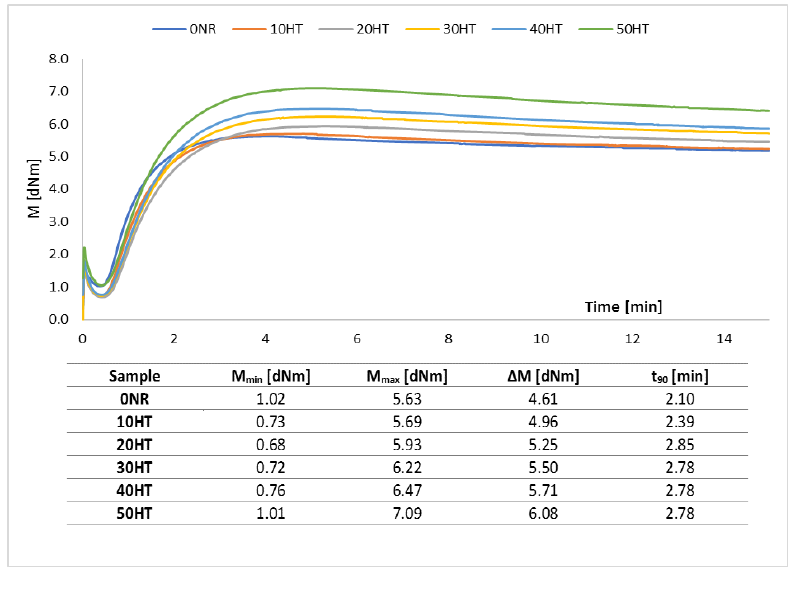
Figure 7. Rheometric curves and curing parameters of tested rubber mixtures.